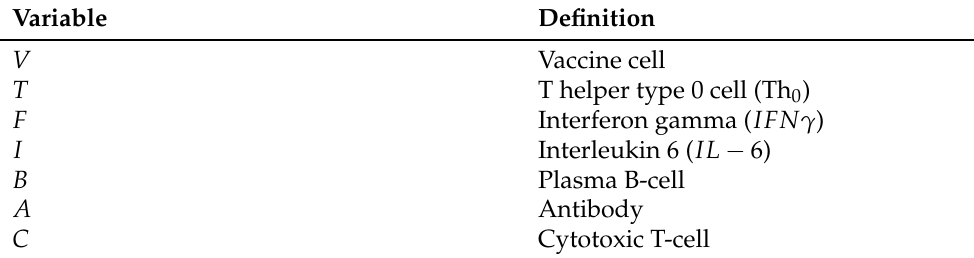
Table 1. Model variables.